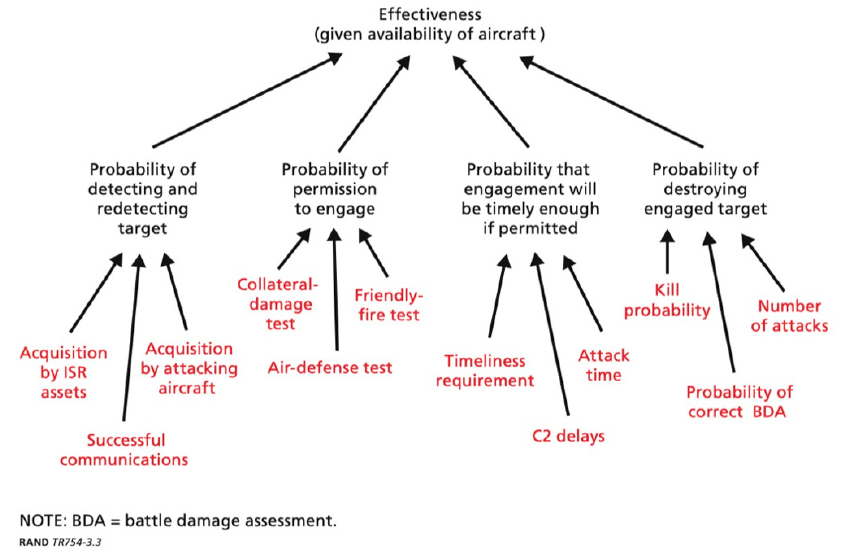
Figure 7. Schematic of a simpler depiction of the problem.